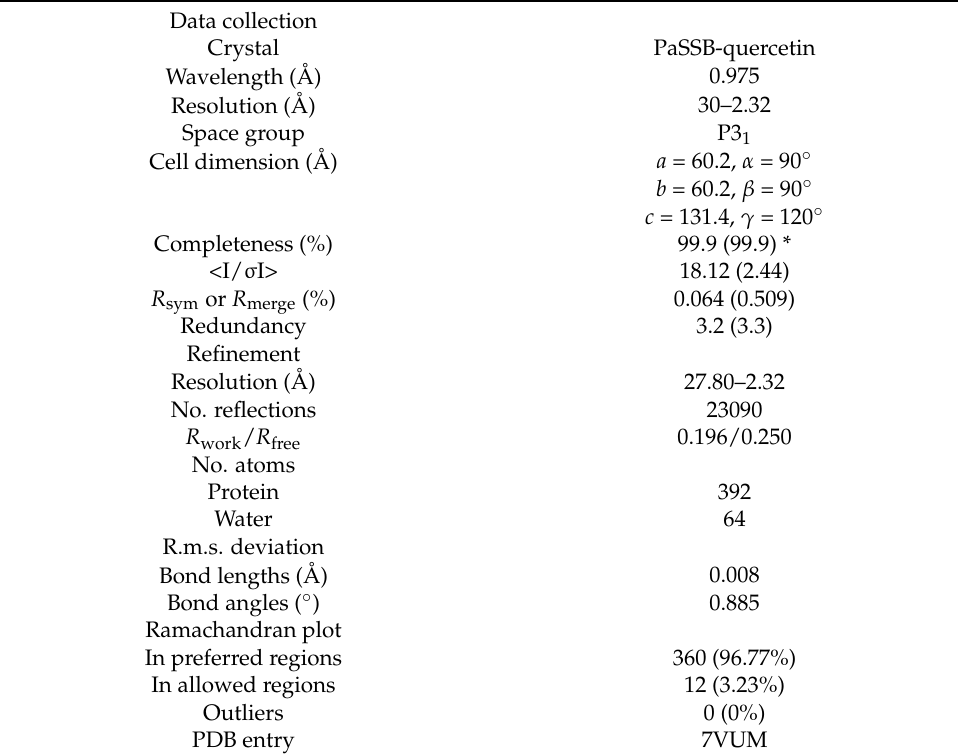
Table 1. Data collection and refinement